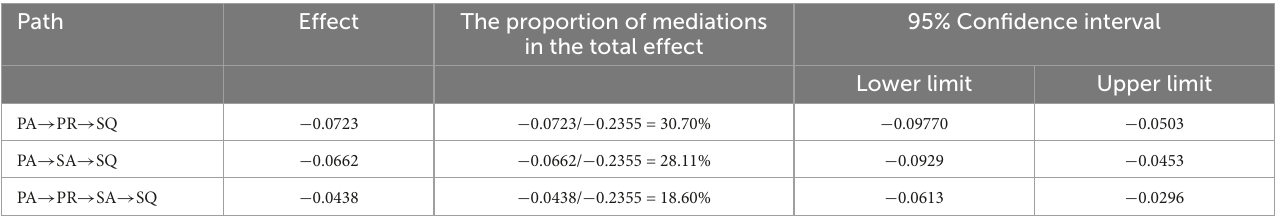
TABLE 4 Mediating effect and effect